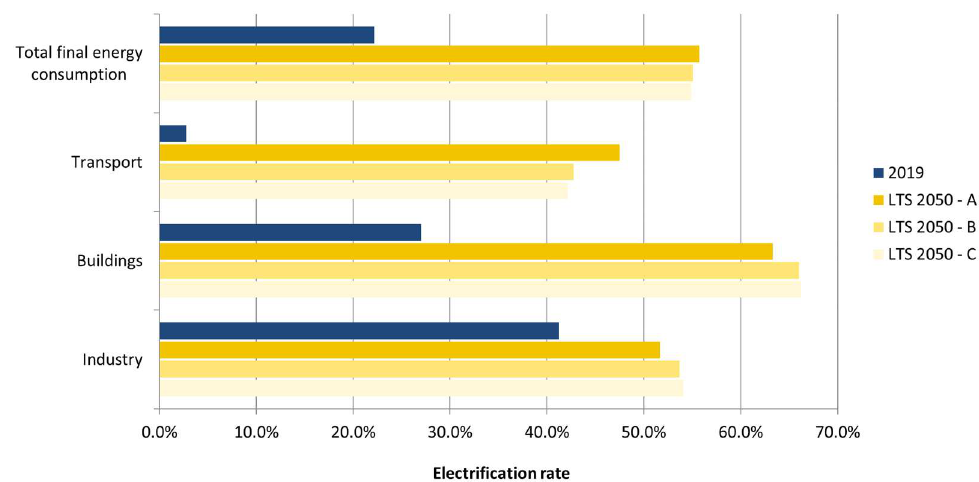
Figure 9. Electrification rates by sector in the 2050 LTS scenarios.